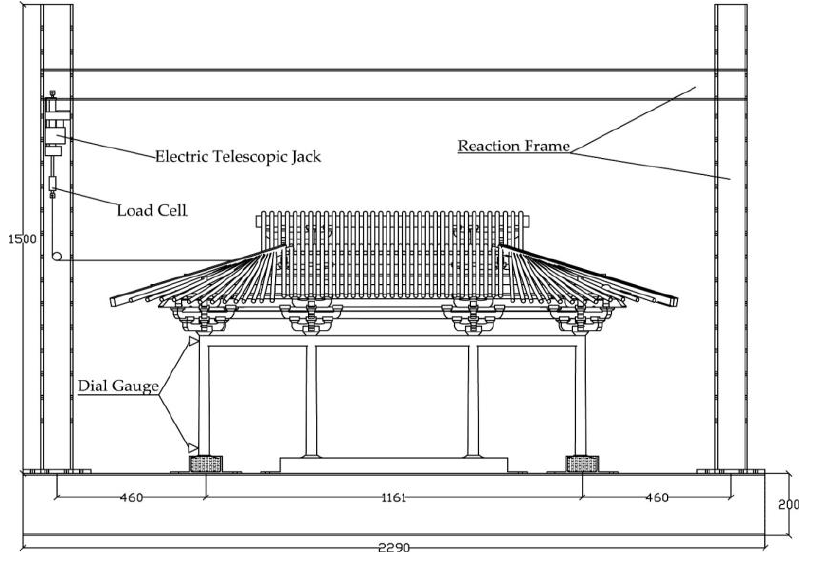
Figure 7. Experimental setup.